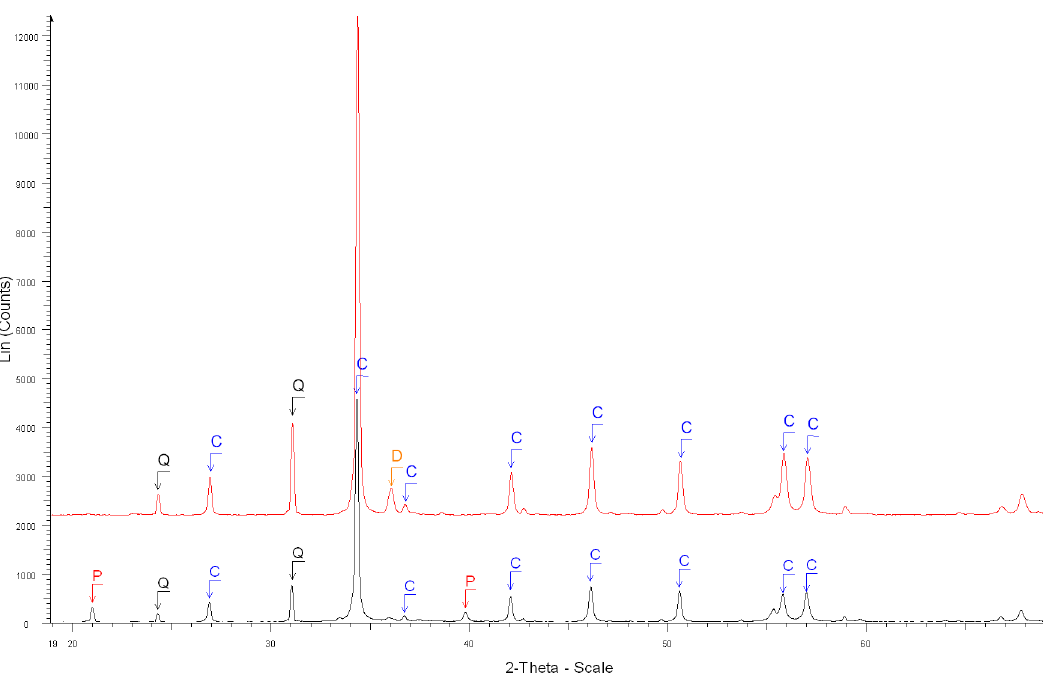
Figure 6. XRD diffractograms: Before (black curve below) and after the dissolution (red curve above) of RCAl_OC1_90 0.63/1.25mm. Q, C, D, and P stand for quartz, calcite, dolomite and portlandite, respectively.